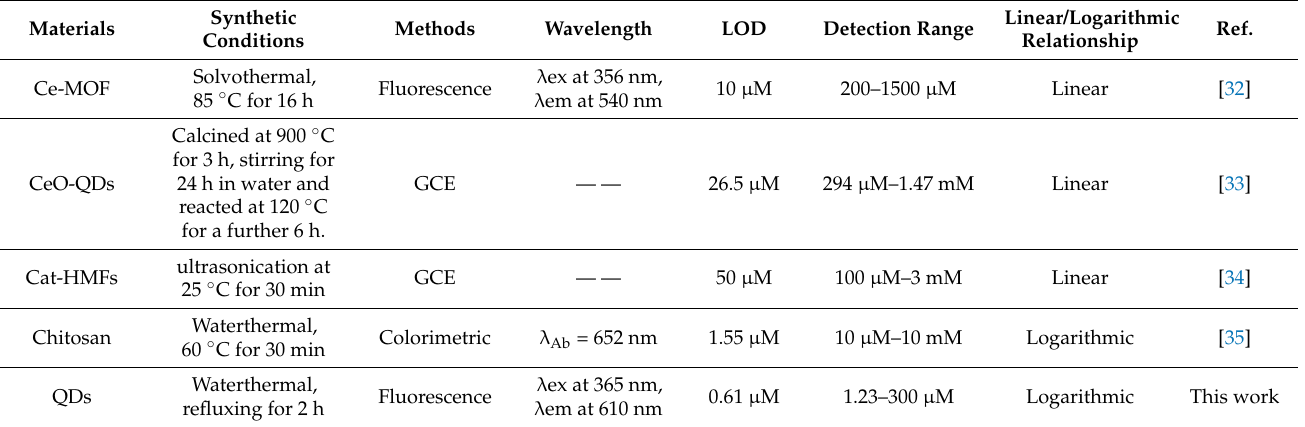
Table 1. Review of methods for detection of H 2 O 2